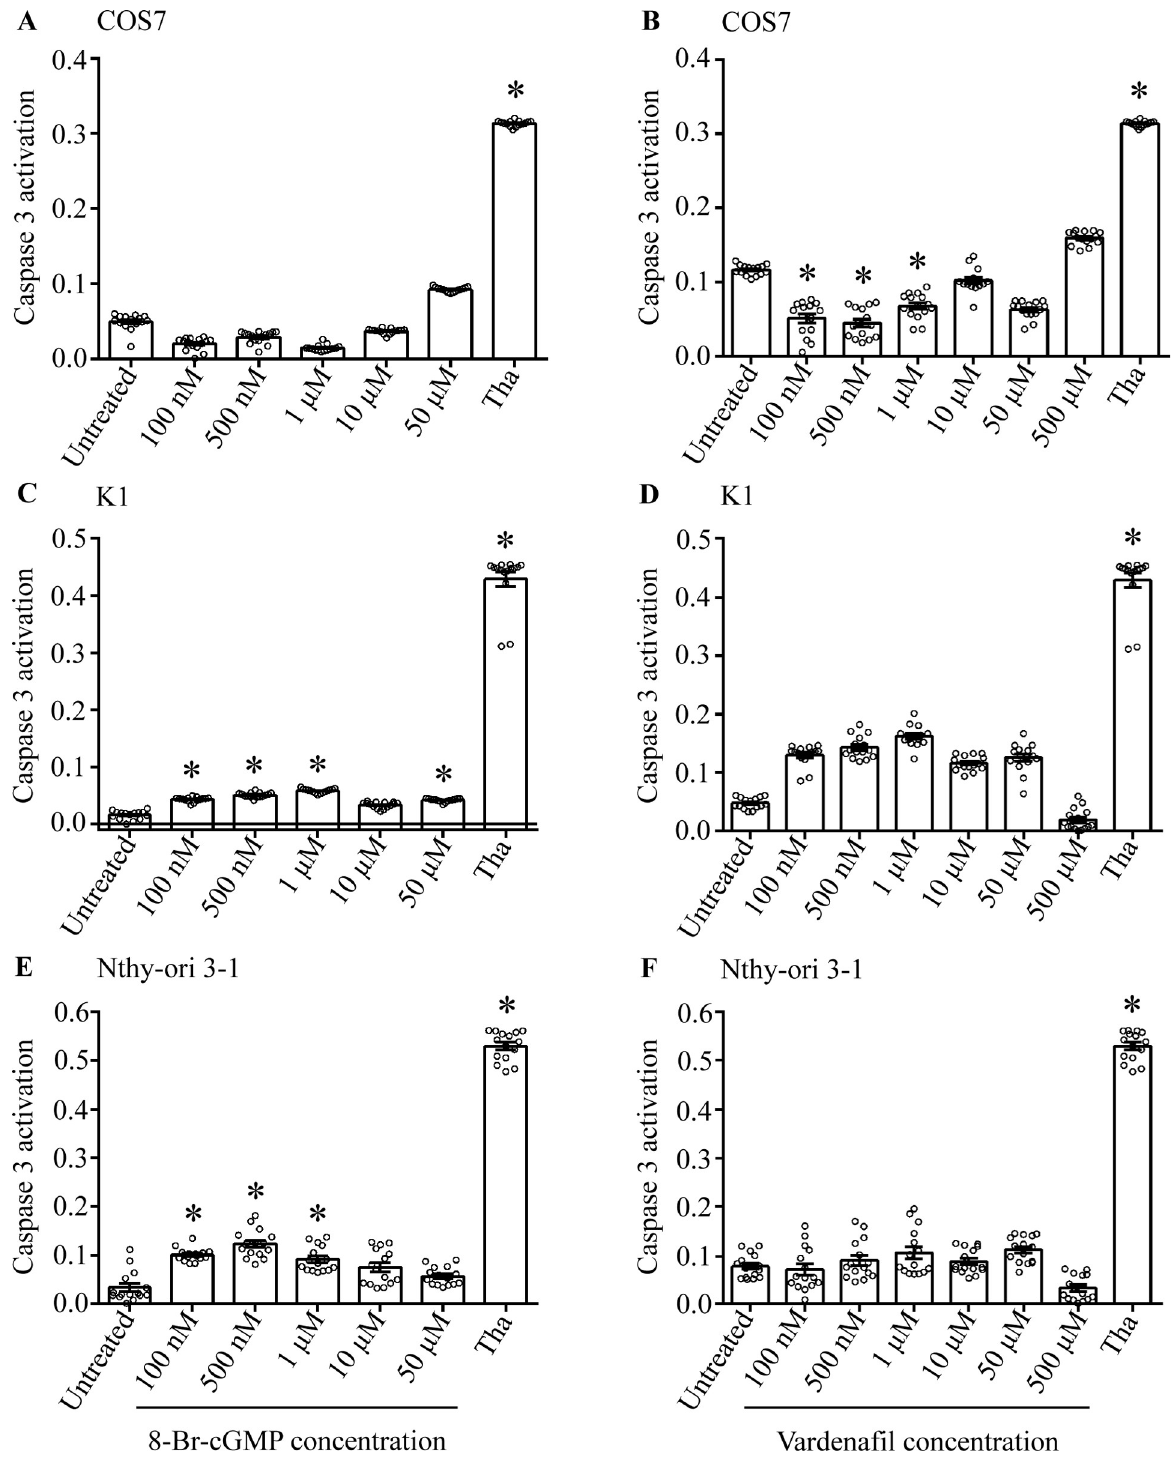
Fig 4. Caspase 3 activity in 8-Br-cGMP/vardenafil-treated COS7, K1 and Nthy-ori 3–1 cell lines. The activity of the enzyme was detected by BRET, in cells treated 4 h with increasing 8-Br-cGMP and vardenafil concentrations (100 nM– 500 μ M range) and expressing a specific biosensor. 4 μ M thapsigargin served as a positive control (Tha). Results were compared by Kruskal Wallis test and Dunn’s post-test ( � significantly different versus untreated sample; p < 0.05; means ± SEM; n = 15). A, B) 8-Br-cGMP- and vardenafil-treated COS7 cells, respectively; C, D) Results from K1 cells; E, F) Nthy-ori 3–1 cell line.